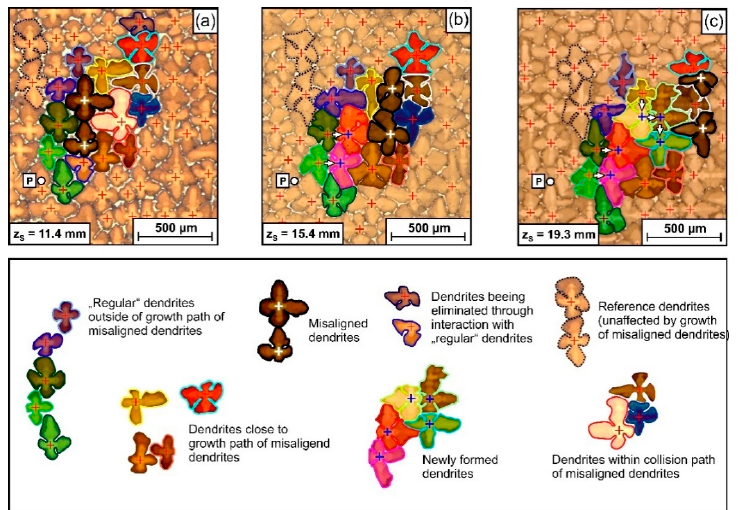
Figure 15. Growth interactions between two slightly misaligned dendrites (dark silhouette, white crosses) with surrounding dendrites during 8 mm of directional solidification growth. Microstructure snapshots at tomographic z S positions of ( a ) 11.4 mm, ( b ) 15.4 mm and ( c ) 19.3 mm. For details, see text.